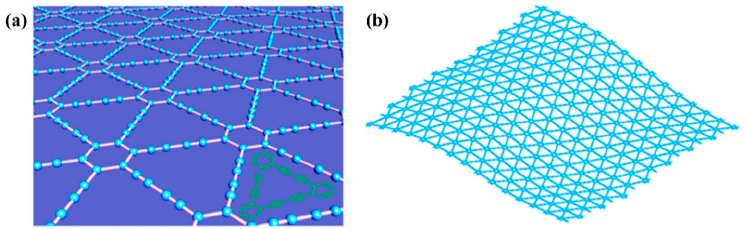
Figure 1. Chemical structure of GDY [31] . (a) Schematic diagram of the two-dimensional planar configuration of the single atomic layer of GDY. (b) Schematic diagram of the folds of the two-dimensional planar configuration of GDY.